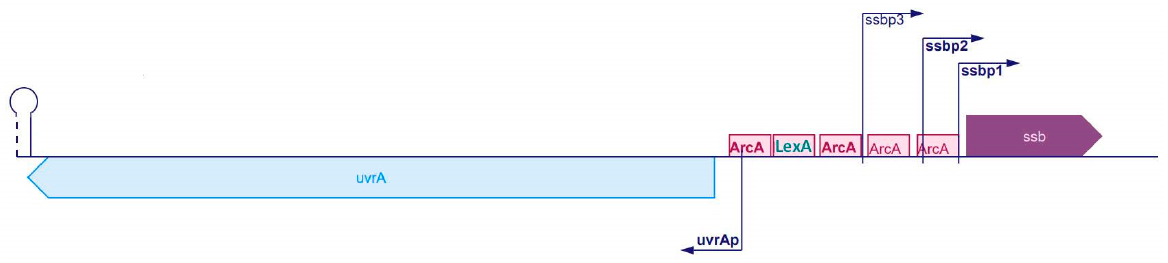
Figure 1. Location of LexA repressor binding sequence, (SOS) box, in relation to ssb and uvrA genes. ArcA is a sequence and onto ArcA a dual transcriptional regulator binds, which inhibits transcription during anaerobic conditions.